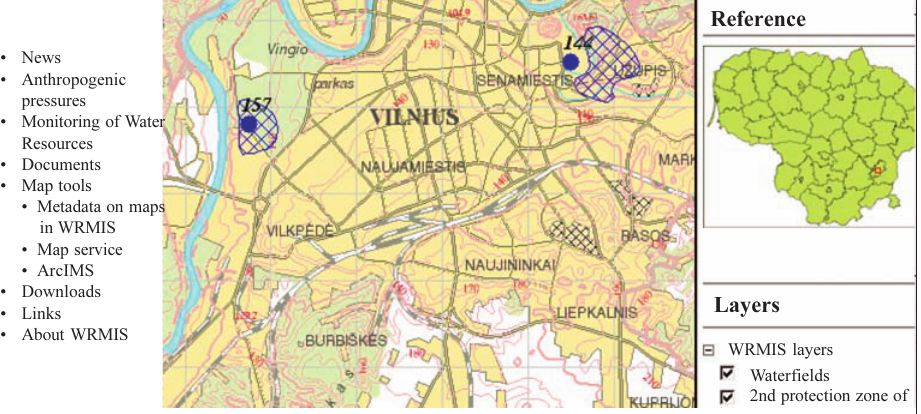
Fig. 6. WRMIS sample screenshot with ground water GIS